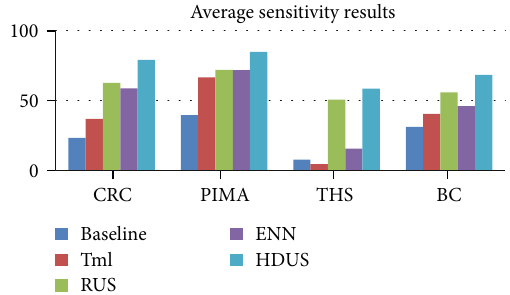
Figure 1: The average sensitivity results using models (baseline, Tml, RUS, ENN, and HDUS) for four